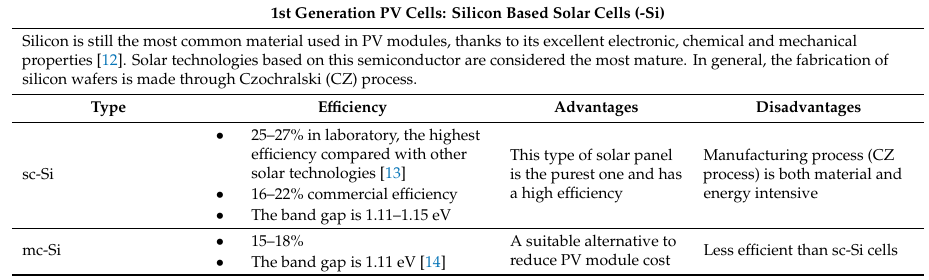
Table 1. First generation PV cells.